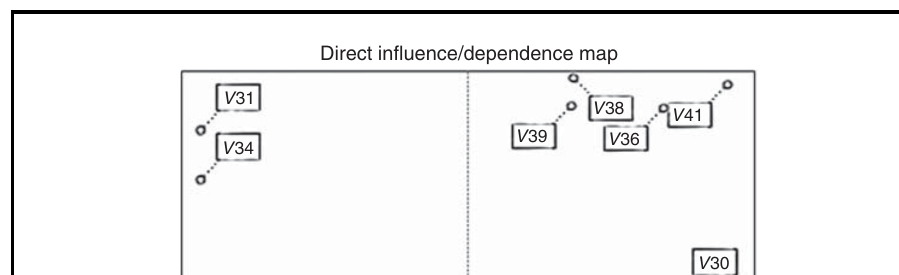
Figure 9 Direct sociocultural negative influence and